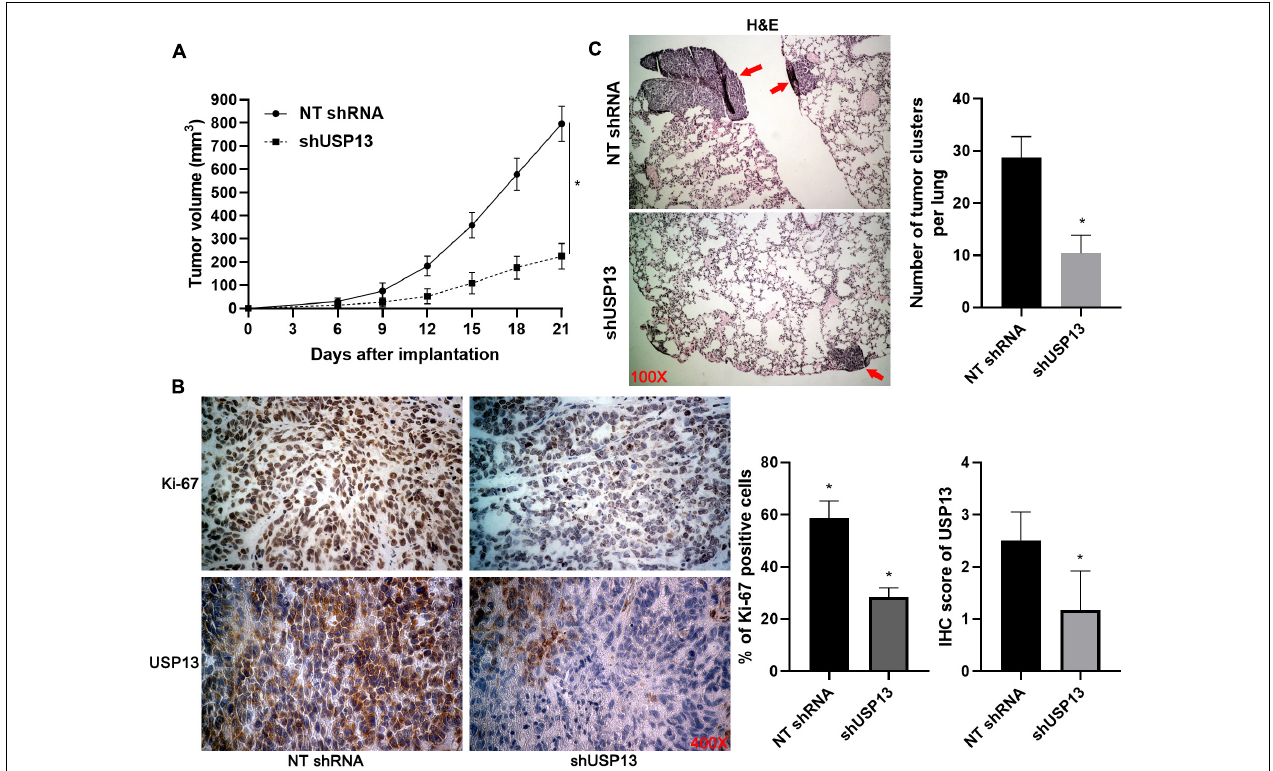
FIGURE 4 | USP13 knockdown inhibits HCC growth and metastasis in mice. (A) Hep3B cells with or without USP13 knockdown were subcutaneously injected into nude mice ( n = 6 for each group). Tumor growth curves indicated that USP13 knockdown restrained HCC growth in vivo . (B) IHC staining of Ki-67 and USP13 was performed in subcutaneous tumor tissues. (C) Hep3B cells with or without USP13 knockdown were injected into nude mice via tail vein ( n = 6 for each group). H&E staining of lung tissues suggested that USP13 knockdown reduced lung metastasis of HCC in mice. * P <